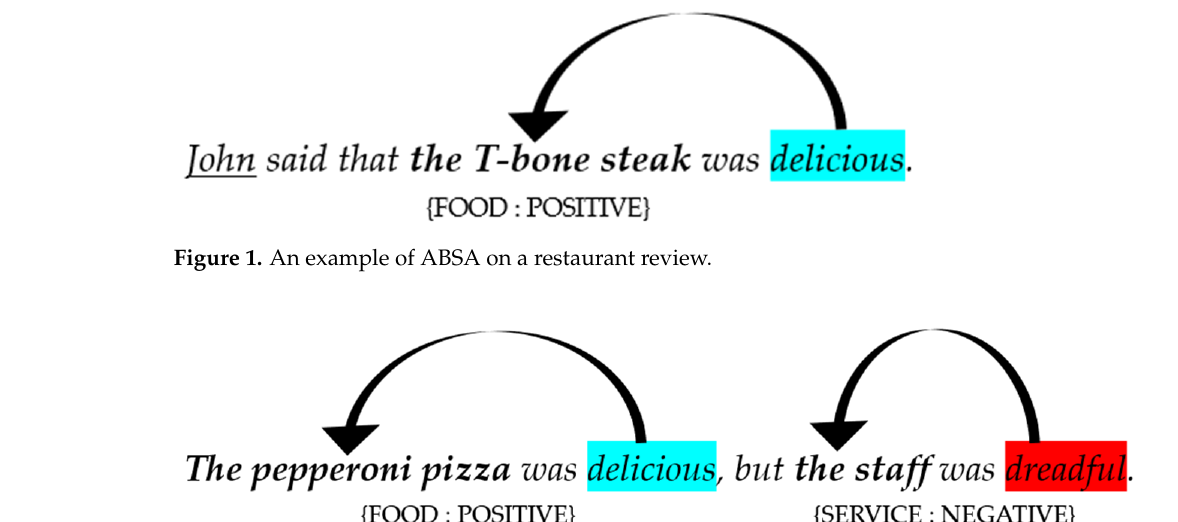
Figure 1. An example of ABSA on a restaurant review.